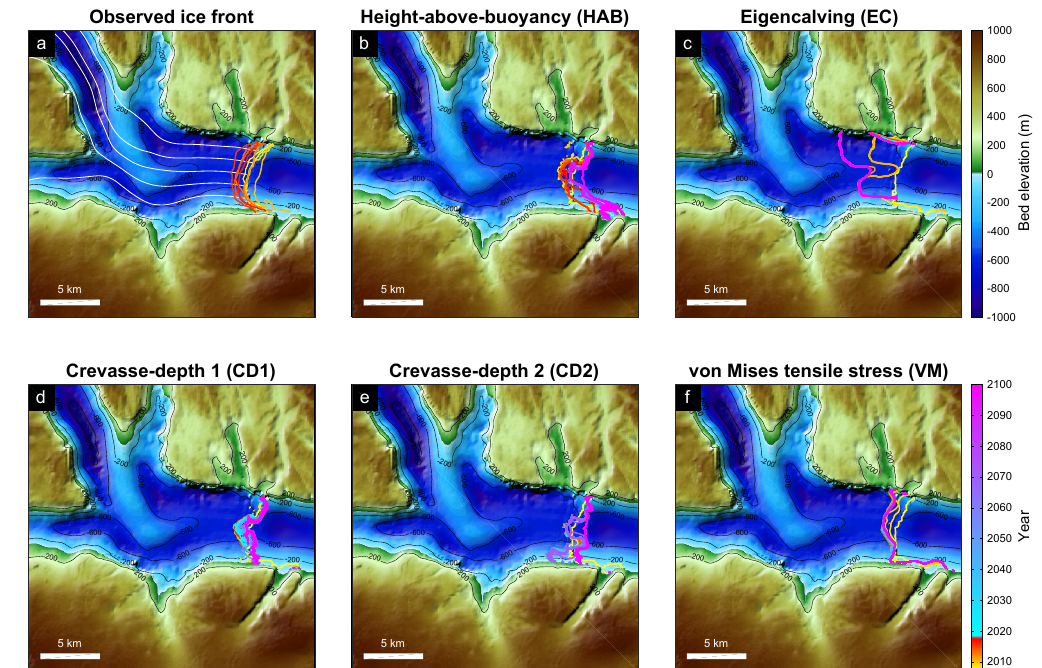
Figure 4. Same as Fig. 2 but for Helheim glacier.